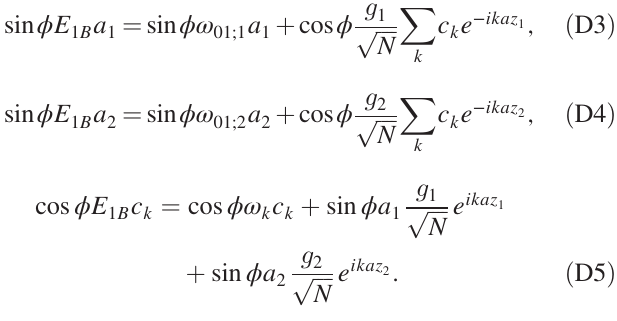
ffiffiffiffiffiffiffiffiffiffiffiffiffiffiffiffiffiffiffiffiffiffiffiffi − E α ð ω 0 1 B Þ